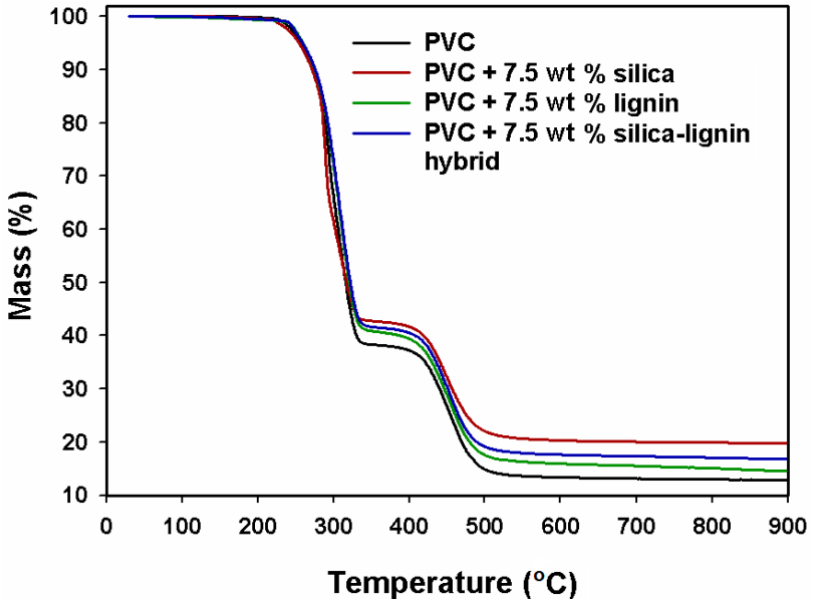
Figure 11. TG curves of PVC and PVC-based composites with a 7.5 wt.% filler content. Reproduced from [83], with the permission of MDPI.